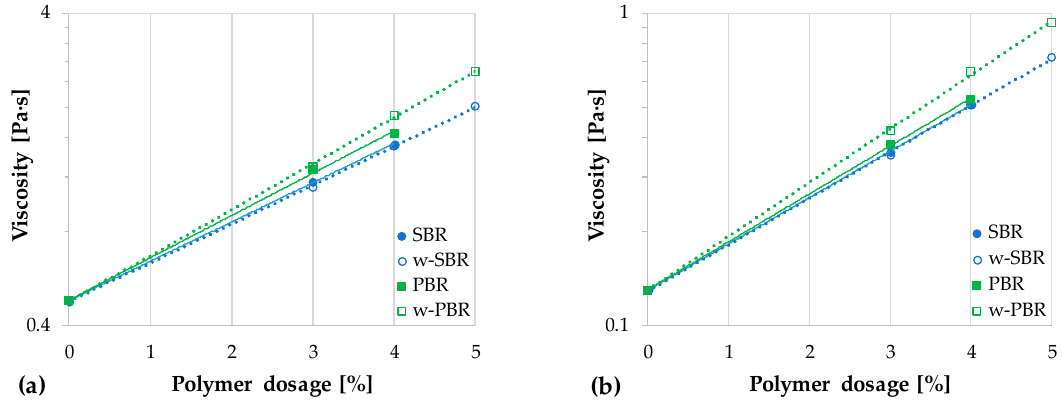
Figure 3. Results of viscosity tests: ( a ) at 135 °C; ( b ) at 165 °C.